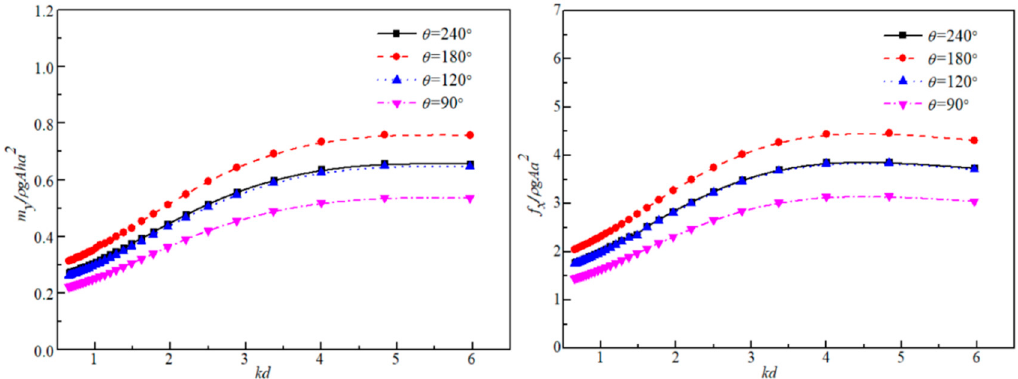
Figure 13. Variation of the wave force and the bending moment on the inner cylinder with different baffle wall angles.